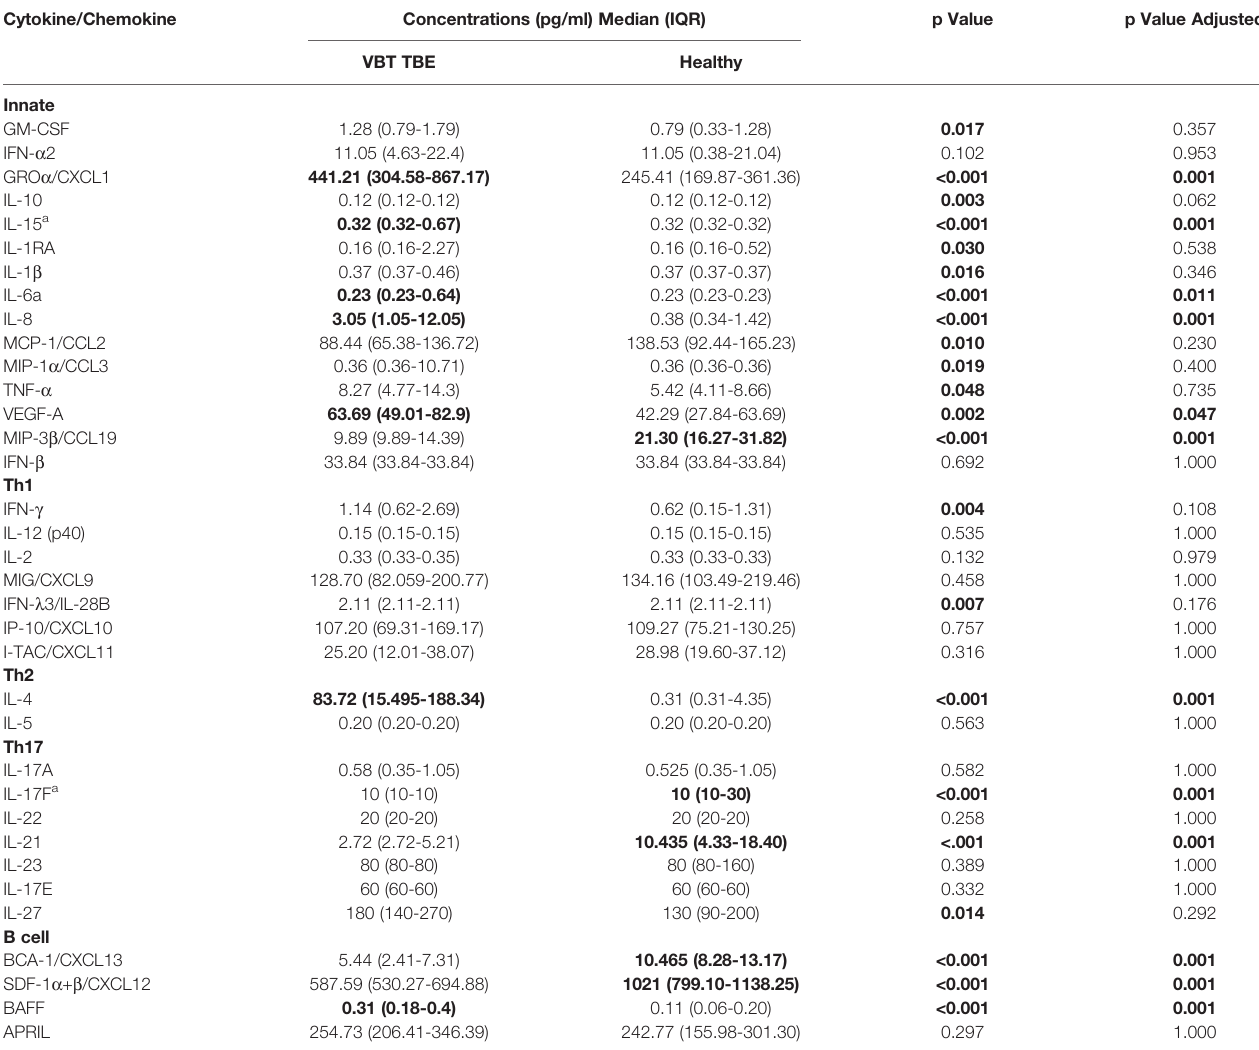
TABLE 2 | Serum concentrations of cytokines/chemokines obtained in patients during meningoencephalic phase of TBE and in healthy controls. Cytokine/Chemokine Concentrations (pg/ml) Median